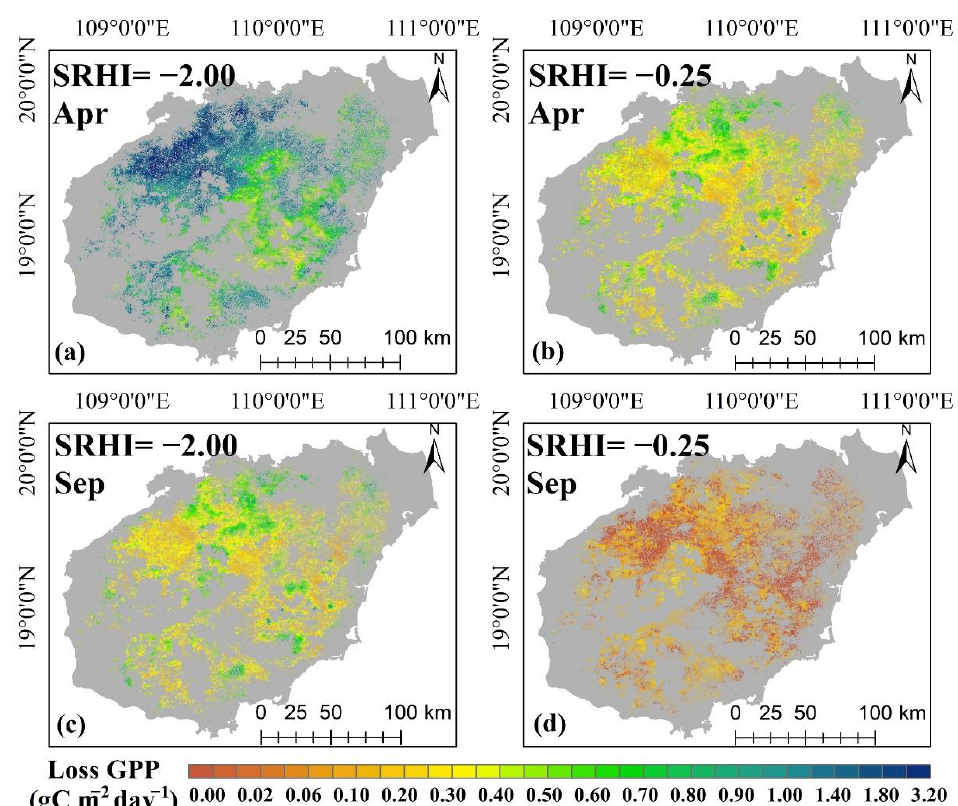
Figure 6. The spatial distribution of a rubber plantation’s GPP loss for different drought months and intensities: ( a ) extreme drought in April; ( b ) light drought in April; ( c ) extreme drought in September; ( d ) light drought in September.